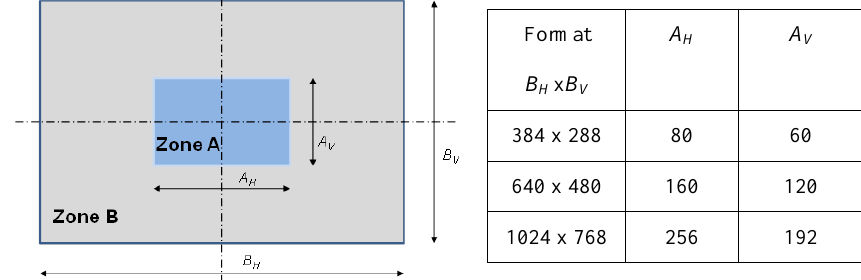
When the shutter is open, the pixel voltage is